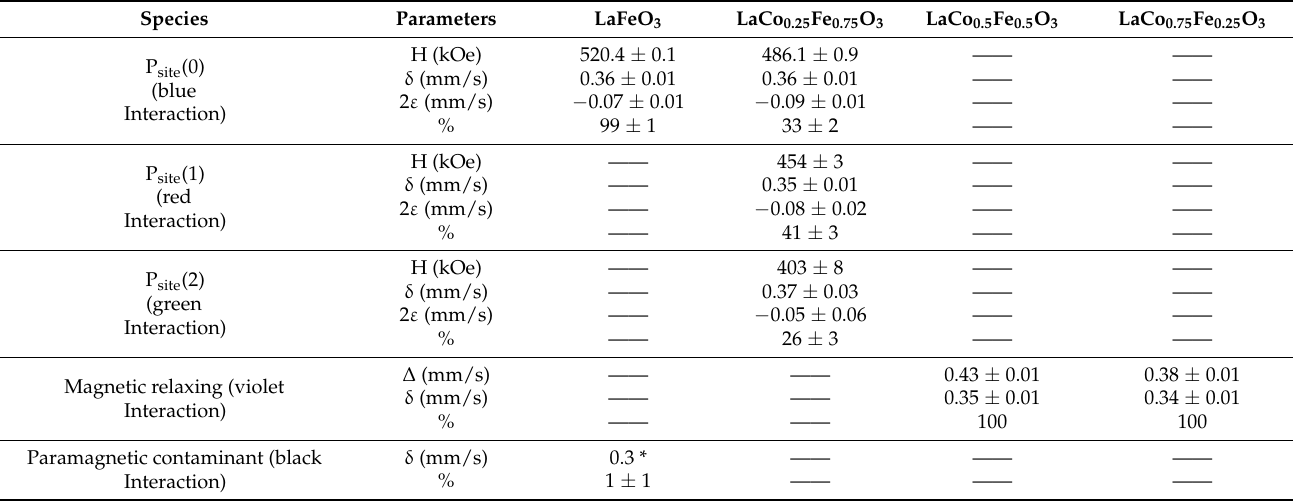
Table 4. Hyperfine Mössbauer parameters of LaFeO 3 , LaCo 0.25 Fe 0.75 O 3 , LaCo 0.5 Fe 0.5 O 3 , and